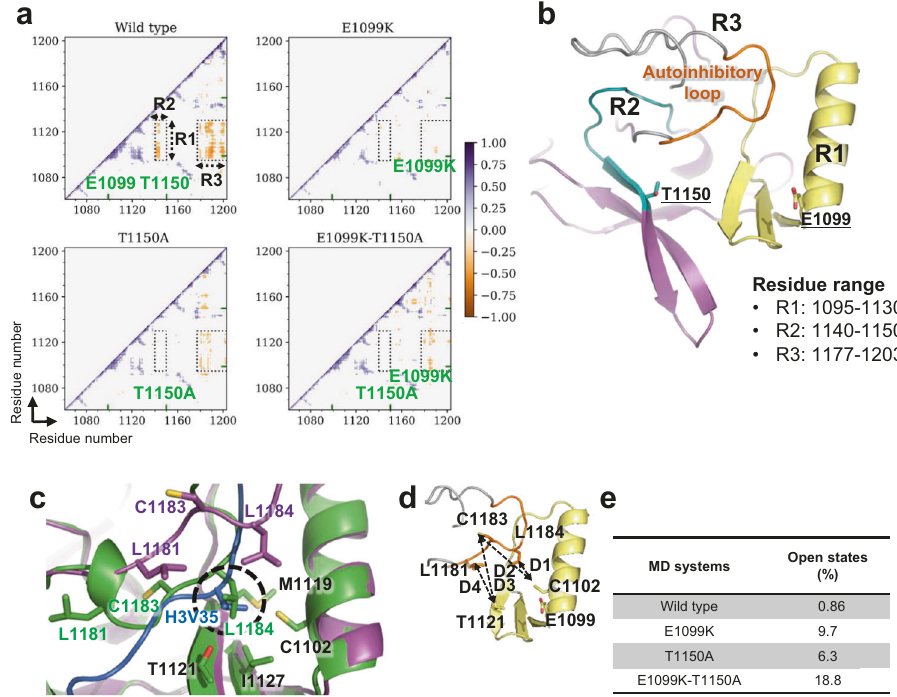
Fig. 5 Opening and closing of the autoinhibitory loop. a 2D plots of the cross-correlation of residue-wise fl uctuations in the NSD2 wild-type, E1099K, T1150A, and double mutant E1099K-T1150A proteins. All the correlation coef fi cients between − 0.3 and 0.3 were taken as zero to visualize the signi fi cantly correlated residues. The regions labeled R1 (residues 1095 – 1130), R2 (residues 1140 – 1150), and R3 (post-SET loop) exhibit a remarkable difference between the wild-type and mutants. The mutation sites are denoted by green ticks on the axis. b The regions R1 (pale yellow), R2 (teal), R3 (gray), the autoinhibitory loop (orange) in R3 and the mutation sites (stick view), are shown and labeled on the NSD2 SET domain structure. c Superimposition of H3- free NSD2 (green) and nucleosome-bound NSD2 (magenta). H3 is shown in marine blue. The overlapping hydrophobic cavity occupied by the L1184 residue in substrate-free NSD2 and H3V35 is circled in black. d De fi nition of four distance-based locks (D1: L1184 – C1102, D2: C1183 – C1102, D3: C1183 – T1121, and D4: L1181 – T1121), as represented by dashed lines in the SET domain structure. The autoinhibitory loop is shown in orange, and residues are labeled. e Table showing the percentage of open autoinhibitory loop conformations observed under different